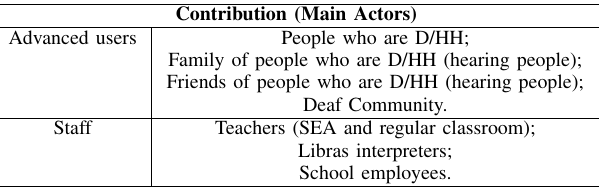
TABLE VIII C ATEGORIZATION OF STAKEHOLDERS IN THE C ONTRIBUTION CIRCLE